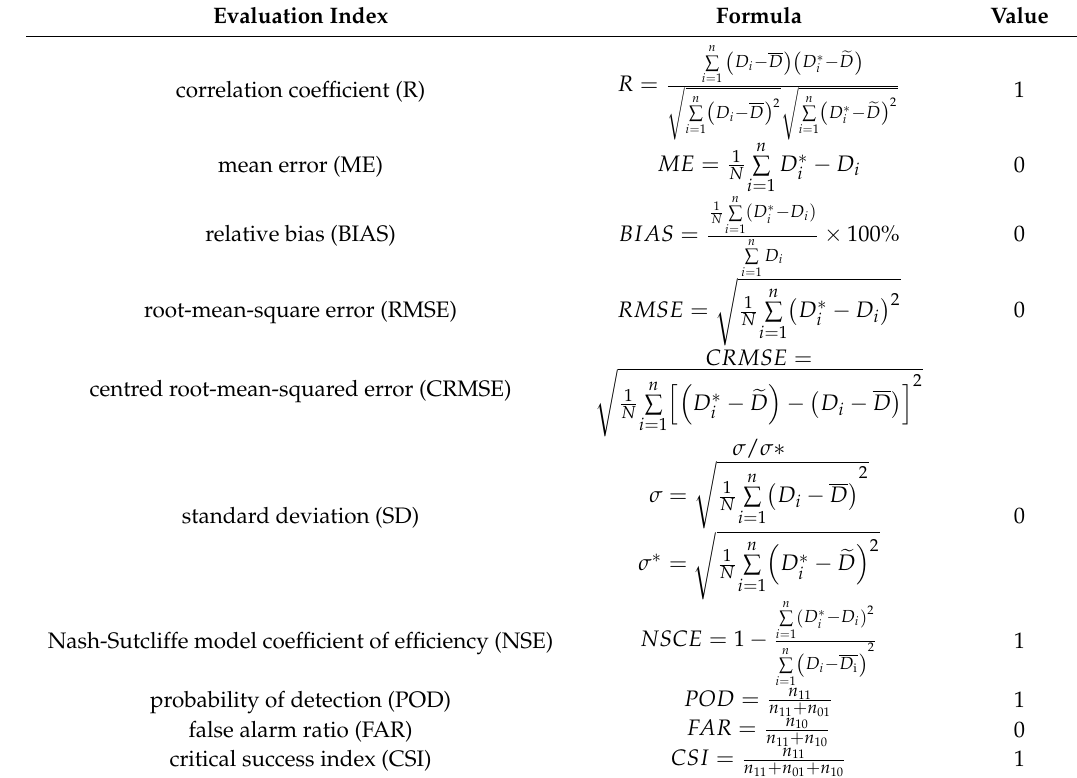
Table 1. List of accuracy assessment